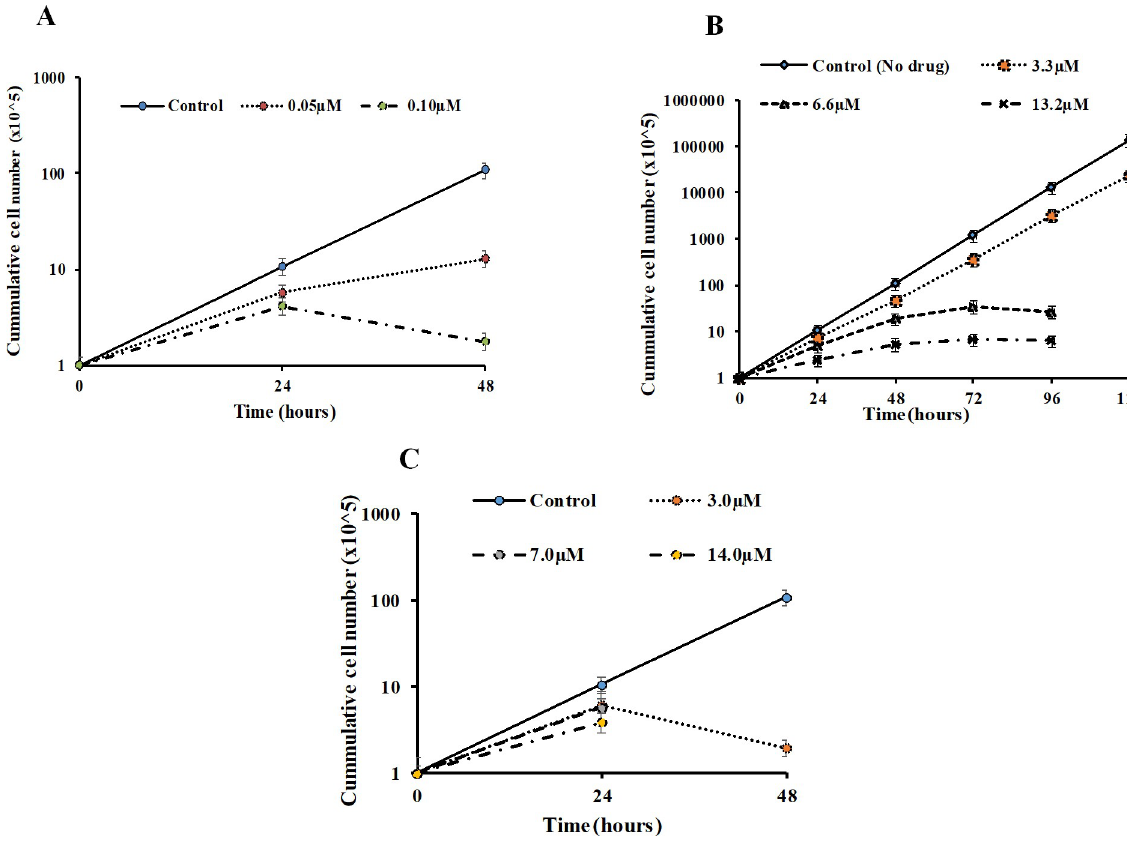
Fig 2. Dose dependent effect of compounds on the proliferation of Trypanosoma brucei brucei . Cumulative growth analysis of trypanosomes in HMI-9 media and 10% FBS in the absence or presence of different concentrations of compounds. (A) Diminazene aceturate (B) Deferoxamine (C) Gallic acid.